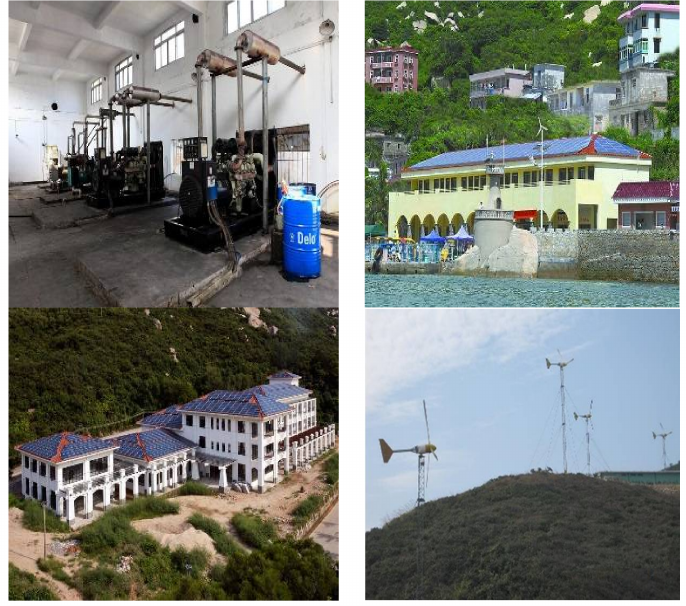
Figure 1. Modular microgrid on DongAo